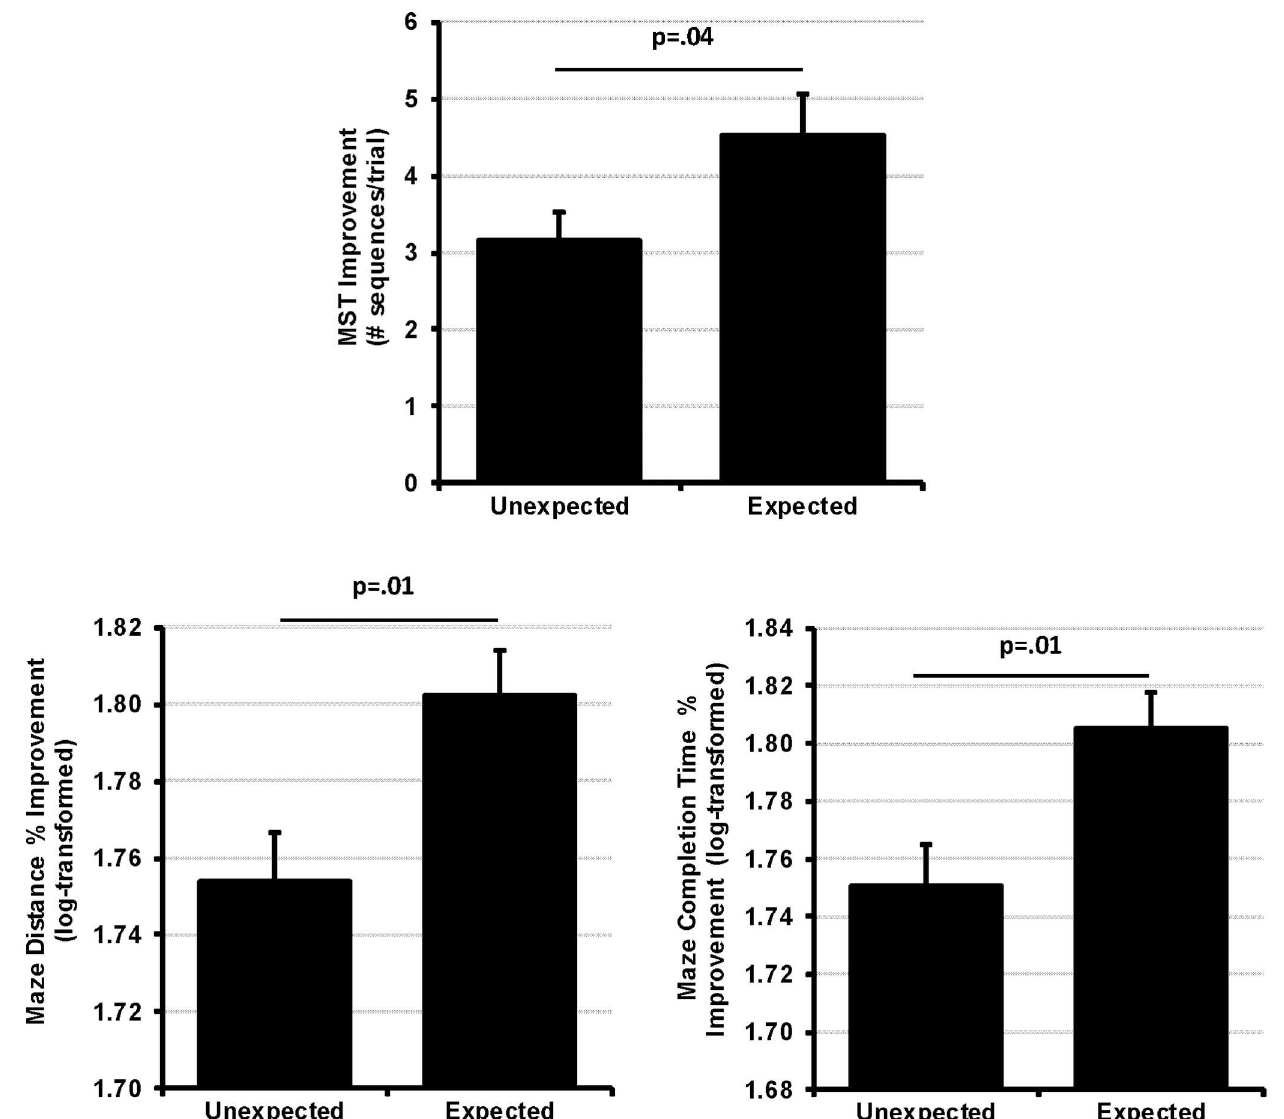
Fig 2. Effect of Expectation on Consolidation. The instruction to expect a future test enhancedperformanceon both the VMT and MST tasks. Error bars ± SEM. For clarity, this figure displays improvement from baseline.Statistical tests utilized an ANCOVA controllingfor baseline